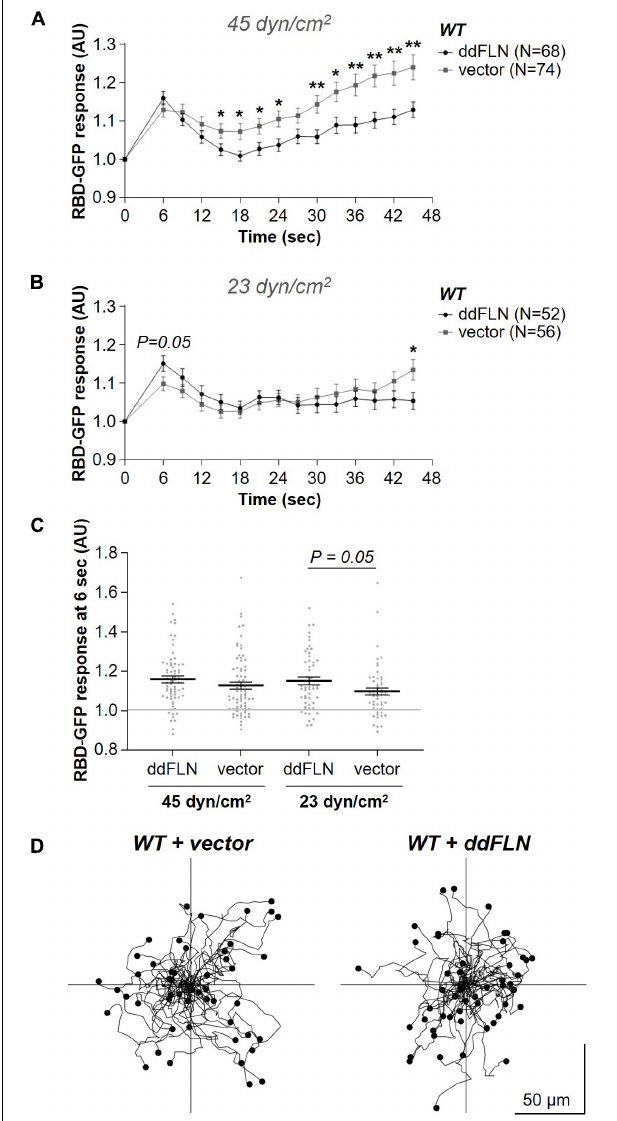
FIGURE 4 | Overexpression of filamin slightly improves activation of the signal transduction network in response to shear flow without affecting the basal activity of the cells. (A–C) Activation of Ras, which reflects activation of the signal transduction network, was measured by the relocalization of RBD-GFP from the cytosol to the cell cortex. Vegetative wild-type (WT) cells expressing RBD-GFP and either mCherry-ddFLN or empty vector were imaged every 3 s by epifluorescence microscopy with a GFP filter set under 630X magnification with oil immersion. The shear stress delivered to the cells was 45 dyn/cm 2 (A) or 23 dyn/cm 2 (B) . Data is displayed as mean ± SE. Number of cells analyzed is provided in the key and was pooled from four (A) or three (B) independent experiments. (C) RBD-GFP response values for individual cells from panels (A,B) at the 6 s time point. Horizontal lines with error bars correspond to mean ± SE. A line at the RBD-GFP response value of 1.0 is shown as a reference to indicate basal levels at time 0. * P < 0.05, ** P < 0.01. (D) The same cells as in panels (A–C) were imaged as they were migrating without any stimulation using brightfield illumination under 200X magnification every 10 s. Tracks of 50 individual cells for each condition from one representative experiment are shown. Average data from three separate experiments is shown in Table 1